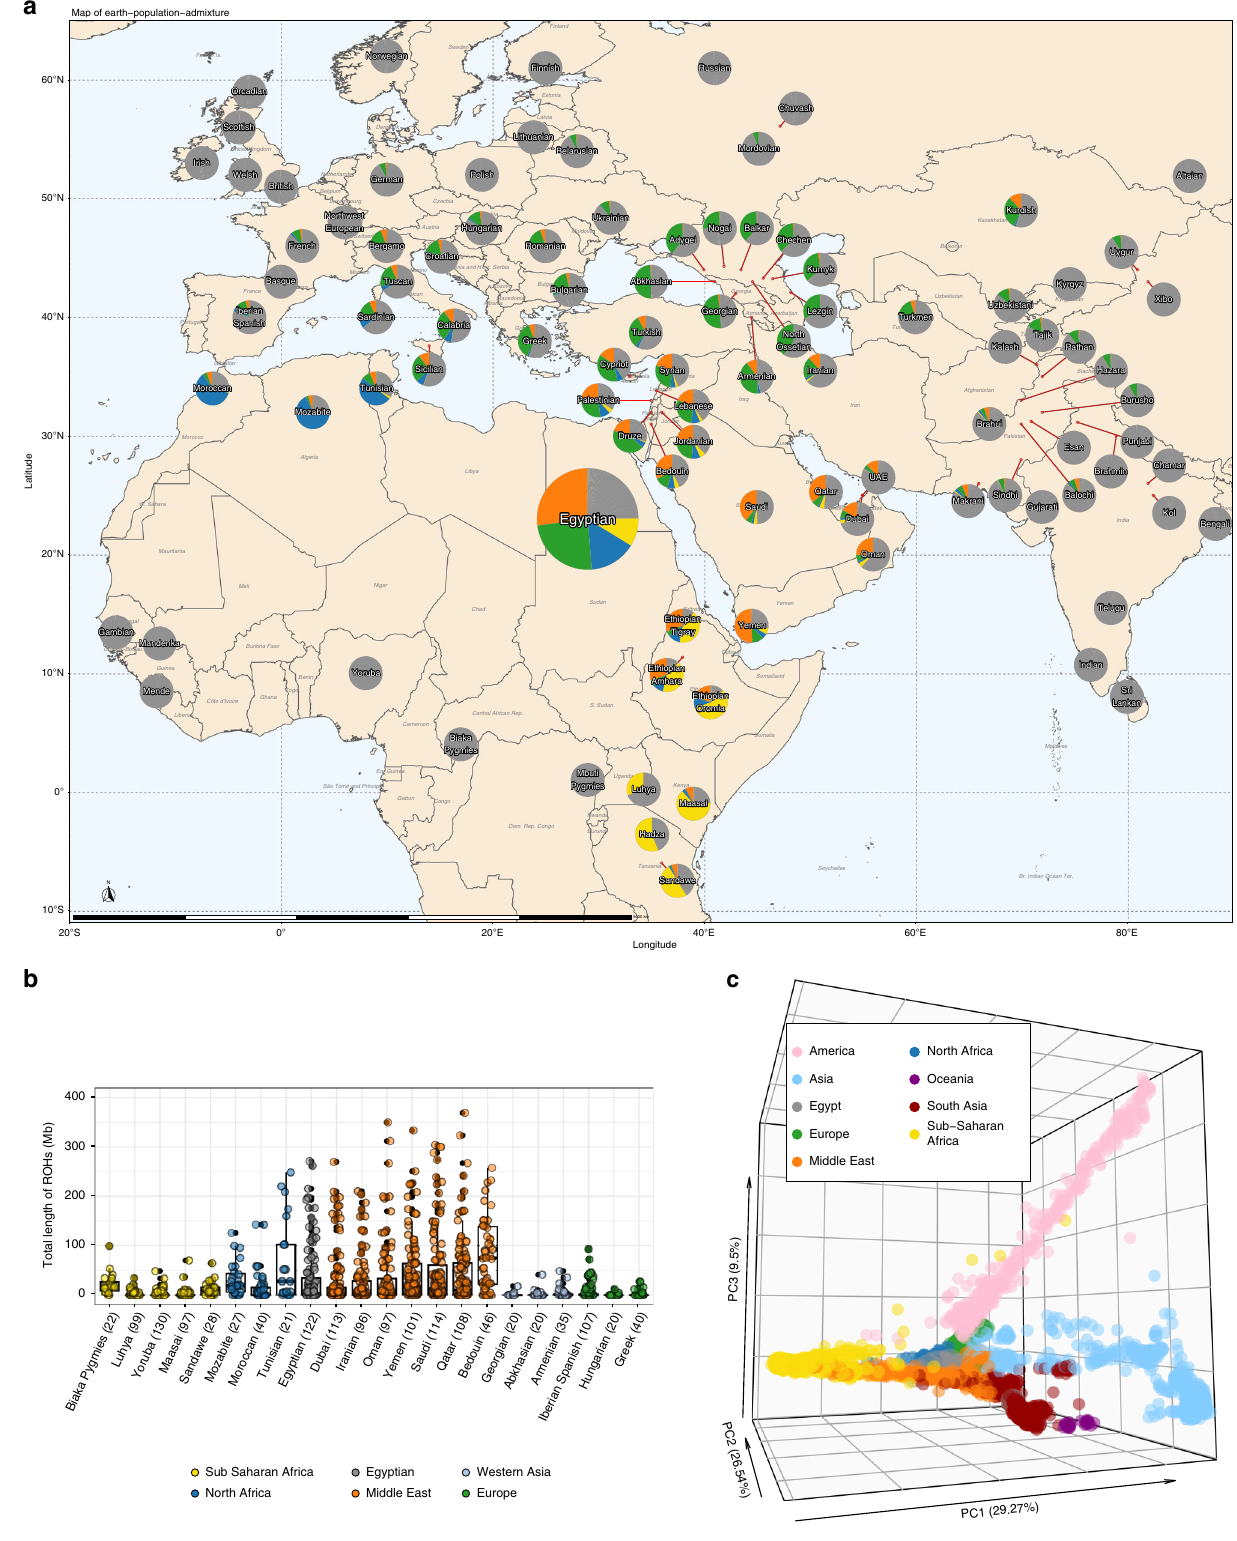
Fig. 2 Population genetic characterization of the Egyptian population. a The four largest ancestry components in the Egyptian population for African, European and Western Asian populations. Colors denote the world region in which the respective component is most prevalent – Orange: Middle East, Green: Eurasia; Blue: North Africa; Yellow: Sub-Saharan Africa. b Box plots for total length of runs of homozygosity (ROH) for the Egyptians and several populations from relevant world regions. Colors denote world regions. The number n of individuals per population is given in brackets. One Qatari individual with a total length of ROH longer than 400Mb is not shown. Box plots display median and lower/upper quartiles; whiskers denote the most extreme data point no more than 1.5 times the interquartile range; outliers are data points extending beyond whiskers. c Principal component analysis with n = 5429 individuals from populations world-wide. The dots are colored according to world